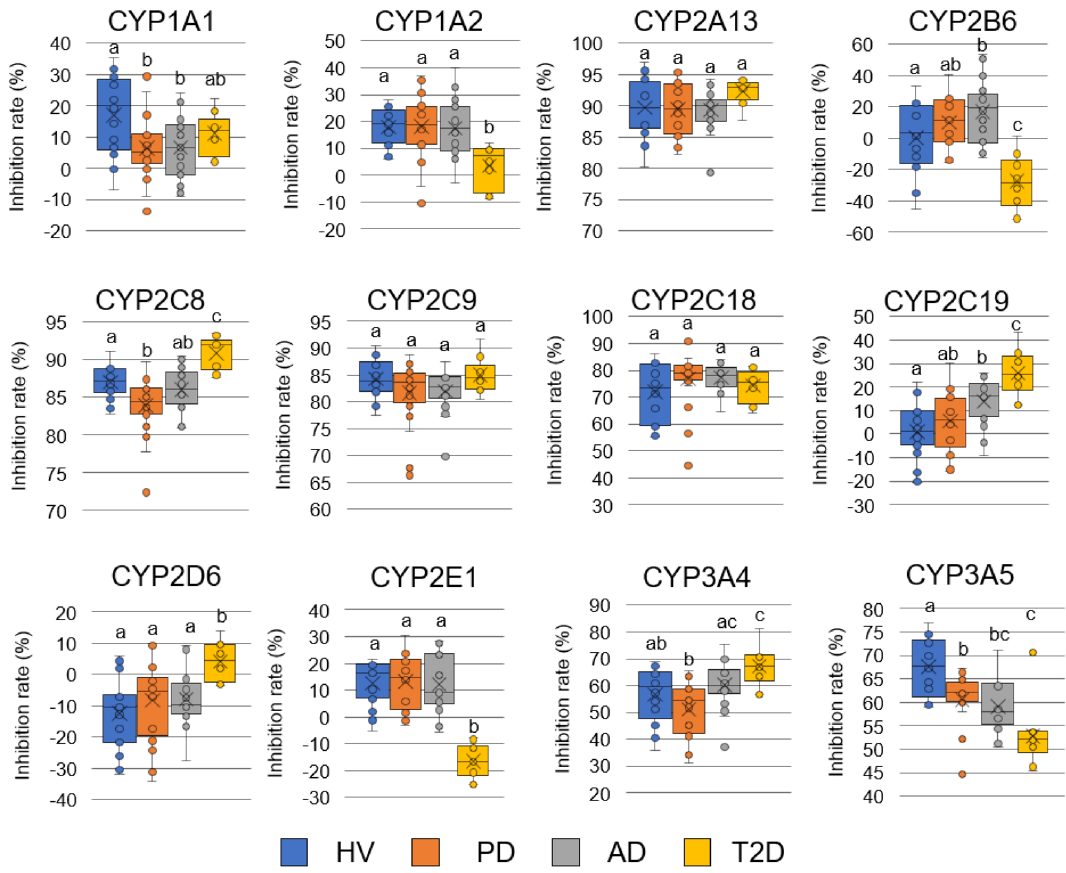
Figure 6. P450 inhibition assays using human clinical samples. Inhibitory rate of reactions in the sera recovered from HVs (n = 20), patients with PD (n = 20), patients with AD (n = 19), and patients with T2D (n = 10) toward 12 types of P450s and fluorescent substrate reactions are presented in a box plot. The black solid bars within the box plot represent the median abundance, and the Cross mark represents the mean abundance. Significant differences were evaluated via Tukey–Kramer test ( P < 0.05). Means having the same letter above the graphs are not significantly different from each other. P450, cytochrome P450; HV, healthy volunteer; PD, Parkinson’s disease; AD, Alzheimer’s disease; T2D, type2